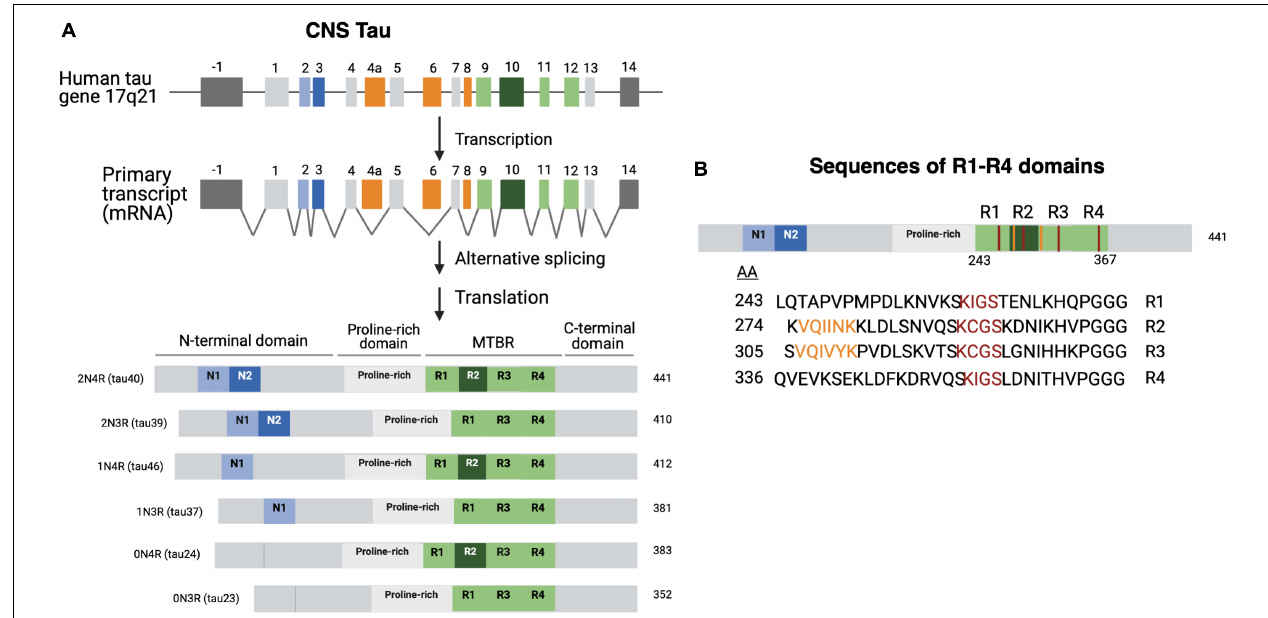
FIGURE 1 | Tau isoforms generated through tau gene expression, alternative RNA splicing, and protein translation. (A) Tau biosynthesis in the CNS. Tau is found on chromosome 17 arm 21. The tau gene contains 16 exons. Exons 1, 4, 5, 7, 13 (light gray) and 9, 11, 12 (light green) are all constitutively transcribed in the CNS (Martin et al., 2011). Exons 9, 11, and 12 encode the R1, R3, and R4 domains, respectively (Martin et al., 2011; Goedert et al., 2017). Exon 10 encodes the R2 domain. Exon -1 is part of the promotor region and is not translated. Exons 4A, 6, and 8 (orange) are mostly expressed in peripheral tissues. Exon 14 is a part of the 3’ untranslated region of the mRNA sequence and is not translated (Goedert et al., 1989; Andreadis, 2005). Tau isoforms are generated by alternate splicing of exons 2 and 3 (light and dark blue) and exon 10 (dark green). The six isoforms range from 352 to 441 amino acids and can be referred to by the clone name as well. Structurally, tau is subdivided into the N-terminal domain, the proline rich domain, microtubule-binding domain region, and the C-terminal domain. (B) R domain MTBR primary sequences. The primary amino acid sequences of the microtubule binding region (MTBR) shows that R1 (243–273), R2 (274–304), R3 (305–335), and R4 (336–367) are partially repeated sequences (Barbier et al., 2019). 275 VQIINK 280 and 306 VQIVYK 311 are two motifs within R2 and R3 that have strong MT interactions and are important for intermolecular β -sheet formation (Moreno-Castillo et al.,